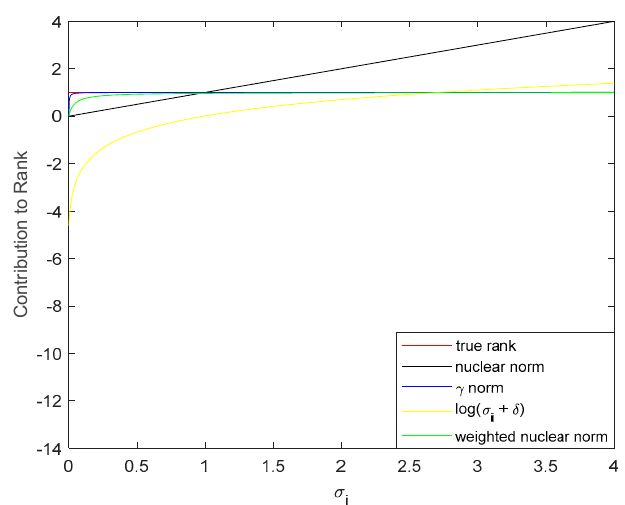
Figure 2. The contribution of different surrogates to the rank with respect to a varying singular value. The true rank is 1 for a nonzero σ i .